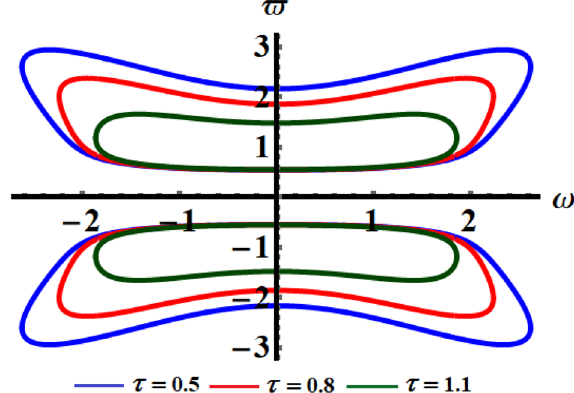
Figure 5. Illustrates the relation between ω and ̟ at τ( = 0.5, 0.8, 1.1 )